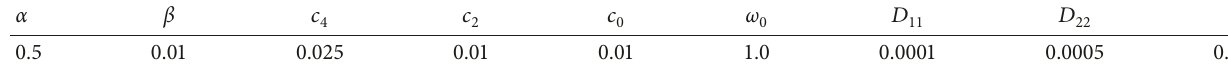
Figure 1: A comparison between the analytical solutions (solid blue lines) and the numerical results (discrete blue Table 1: Parameter values used in simulation.